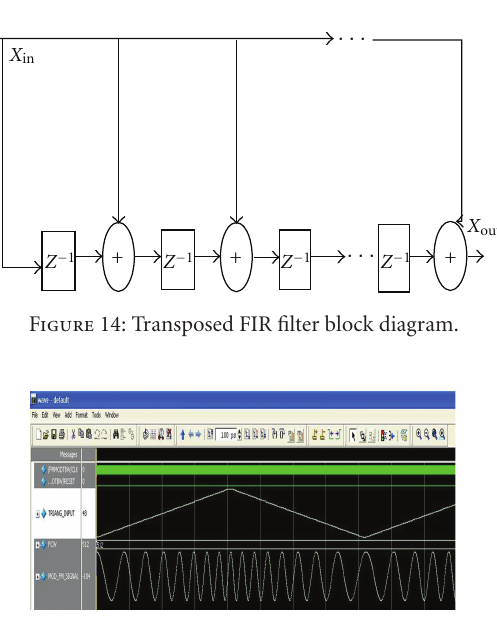
Figure 15: Simulation result of digital FM